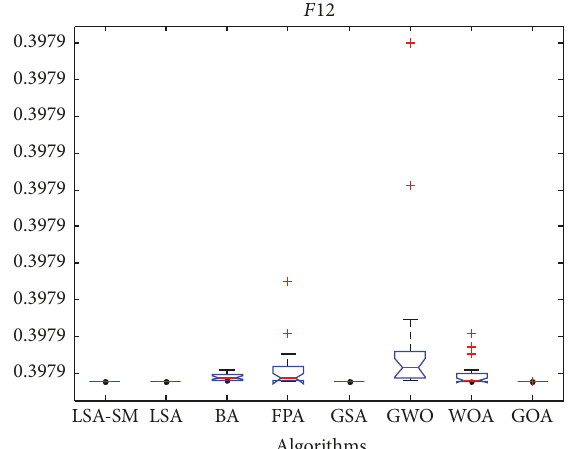
Figure 37: 𝐷 = 6 , ANOVA test of global minimum for 𝑓 15 .